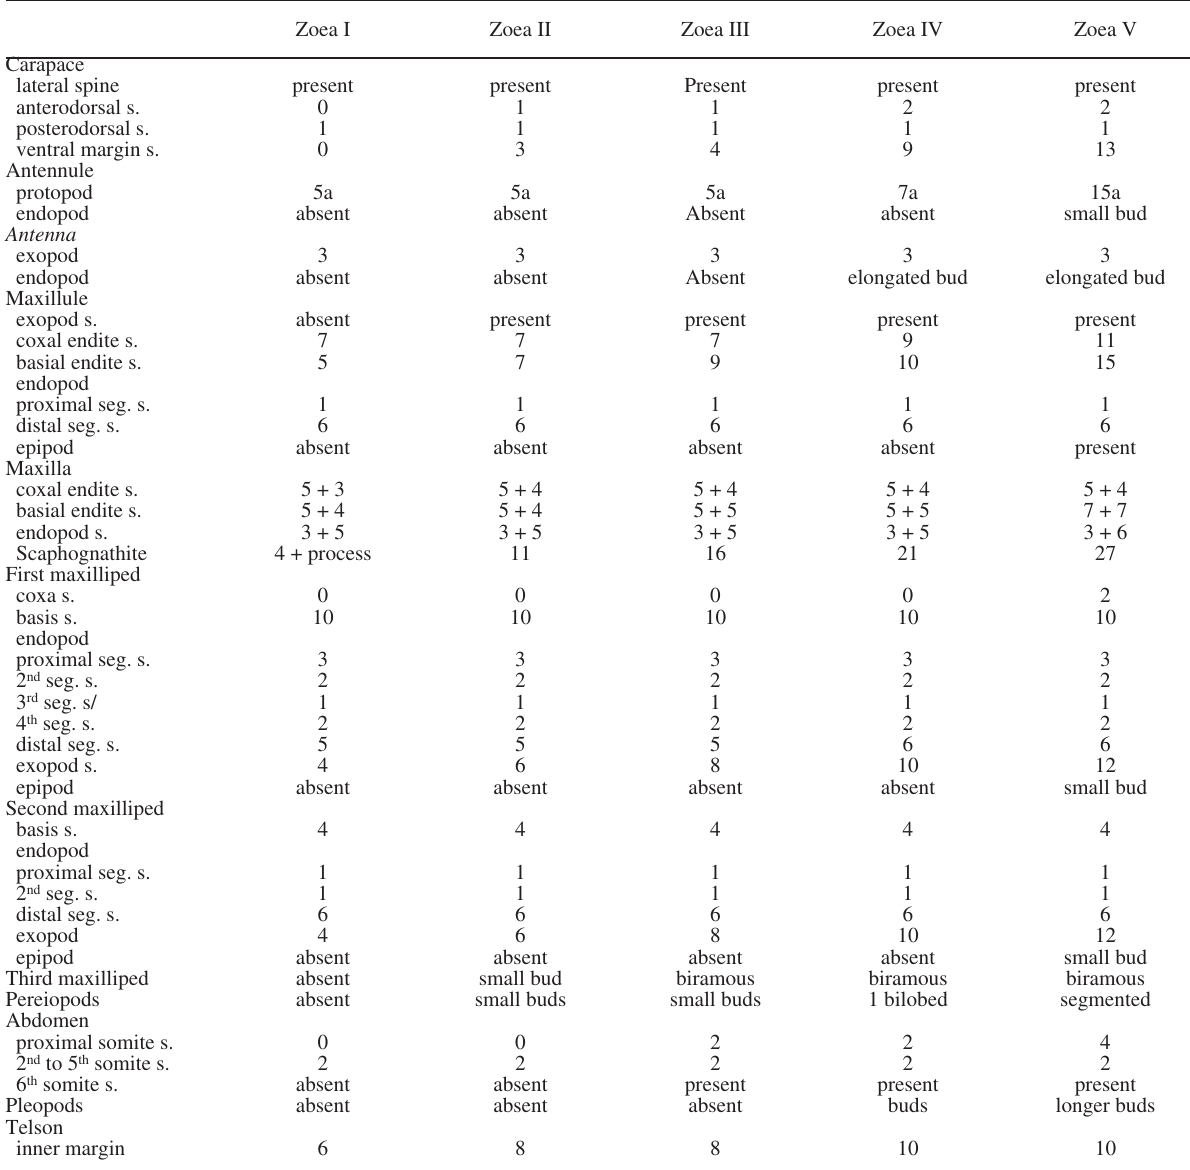
Table 2. – morphological features and setation formulae of the zoeal development of Pilumnoides hassleri . Abbrevations: s, setae; a, aes- thetasc; seg., segment.